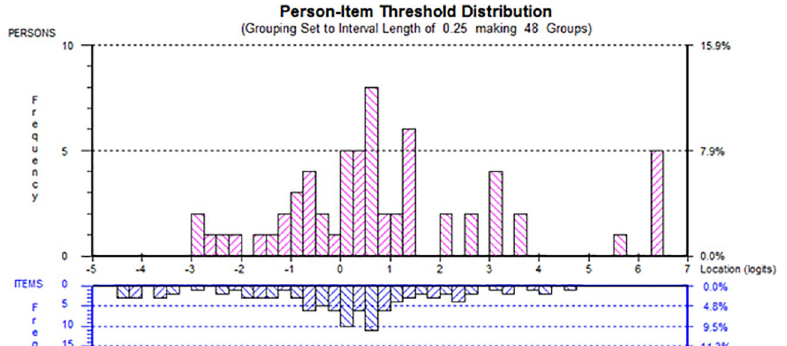
Fig 3. Person-item threshold distribution of the SCCCS. Person-Item thresholds. The items are shown at the reversed histogram at the bottom and the patient samples is shown in the top histogram. The figure shows that targeting between person (top) and the items (bottom). There is a lack of coverage of items at the highest degree of compassionate care.